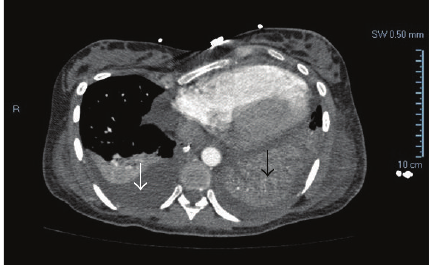
Figure 3: Axial chest computed tomography scan with intravenous contrast revealing right pleural effusion (white arrow) and left pleural effusion with consolidation (black